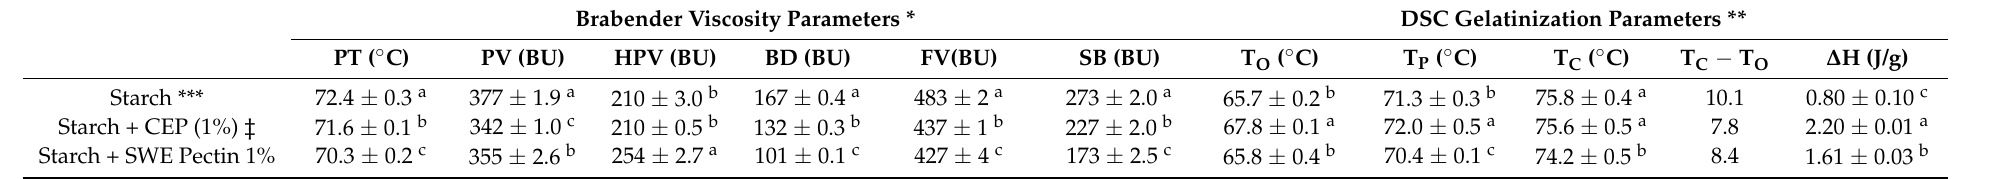
Table 3. Brabender and DSC gelatinization parameters of native starch and pectin starch